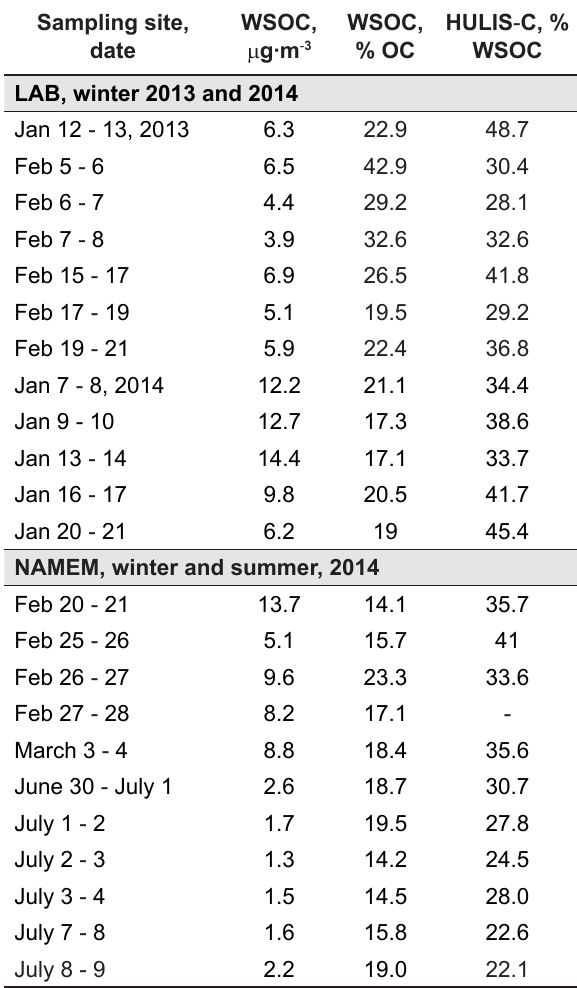
Table 2. WSOC and HULIS contents in